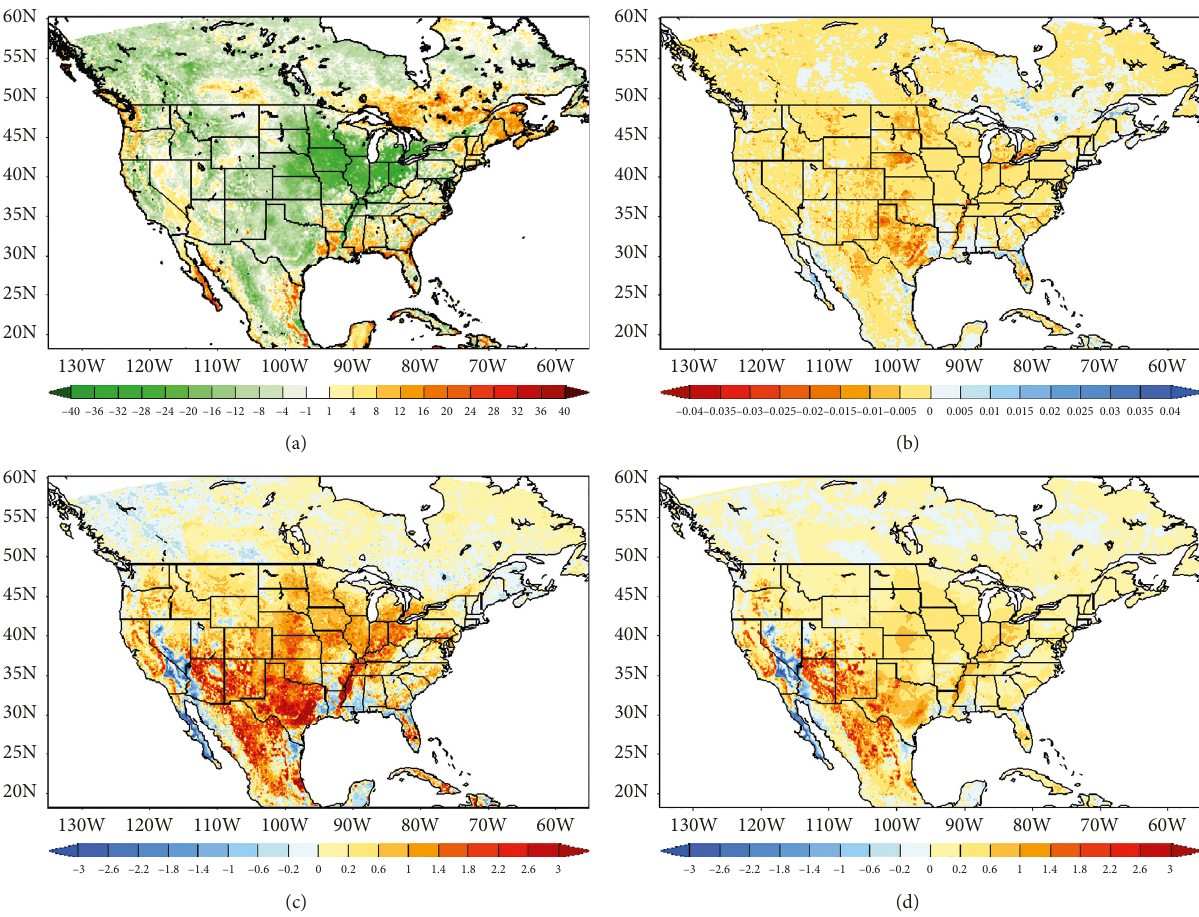
Figure 4: Differences of the WRF-NRTand WRF-Clim runs averaged from 3 October–9 October 2015: (a) GVF input ( soil moisture output (